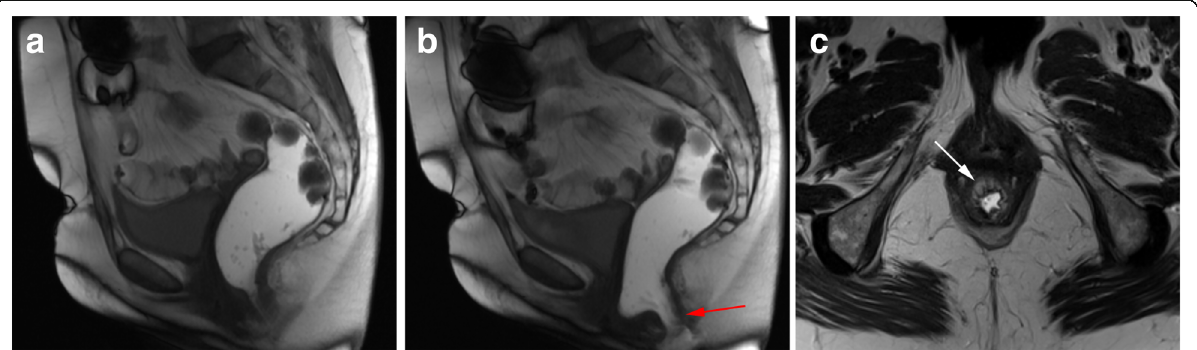
Fig. 23 Anal incontinence. ( a , b ) Sagittal midline TrueFISP images at rest ( a ) and during Valsava maneuver ( b ), with loss of the ultrasound gel in the second one. Notice the opening of the anal sphincter (red arrow). ( c ) Axial T2-TSE image of the internal anal sphincter demonstrating atrophy with lipomatous involution of the sphincter muscles (white arrow)